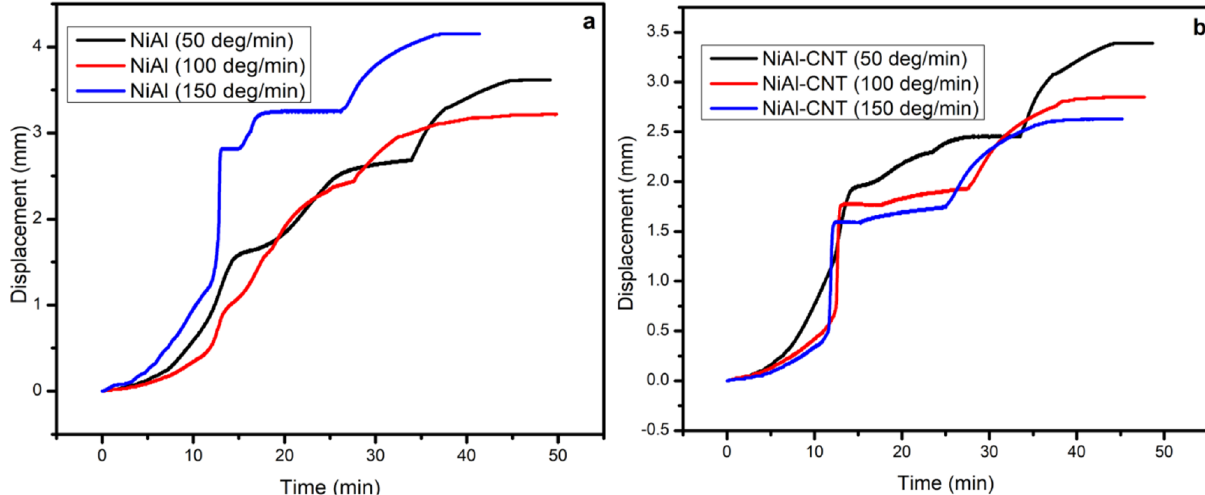
Fig. 1. The plot of the displacement against time at different heating rate (a) NiAl, and (b) NiAl-CNT.